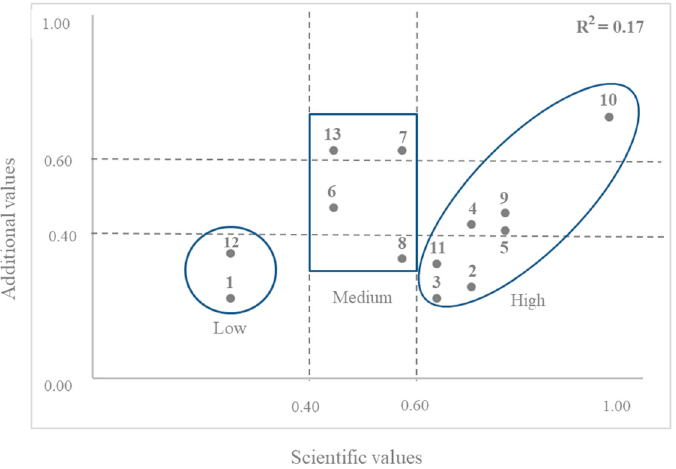
Figure 8. Correlation between scientific and additional values of sedimentary aeolian systems from Tenerife volcanic island.